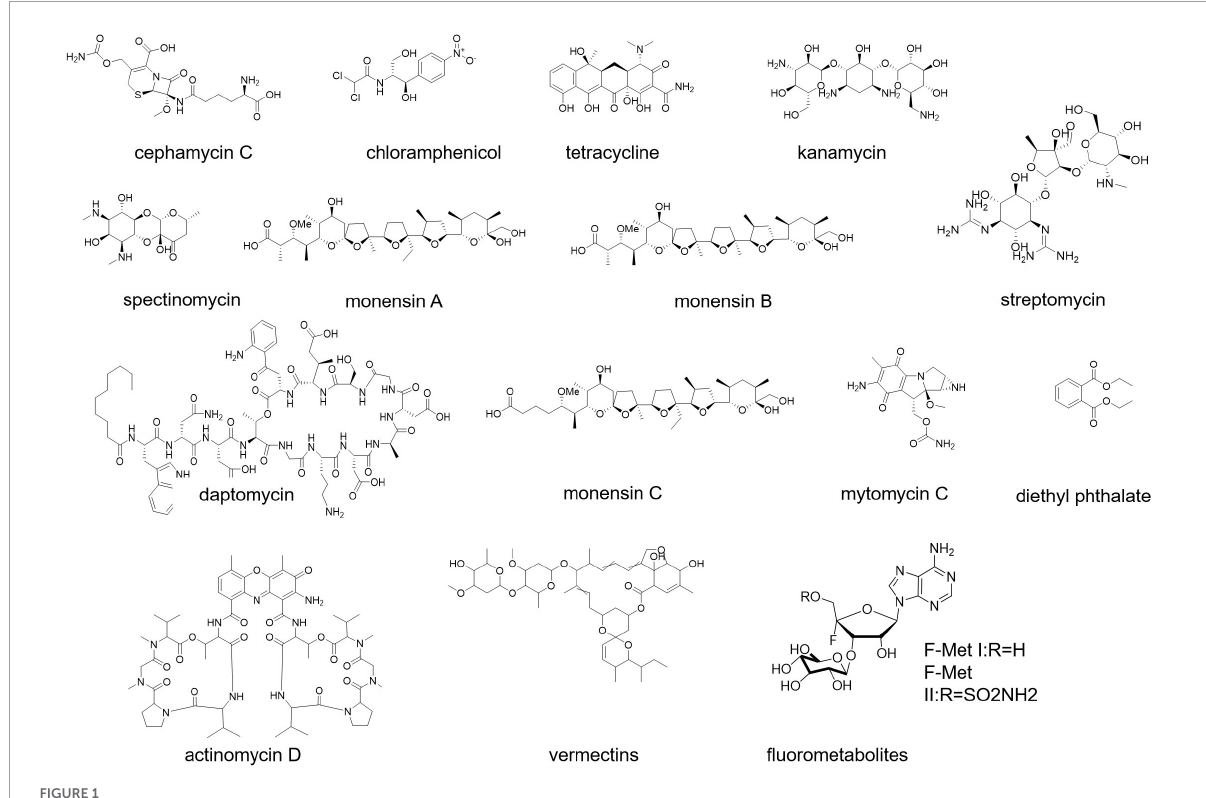
FIGURE1 Antibiotics from Streptomyces